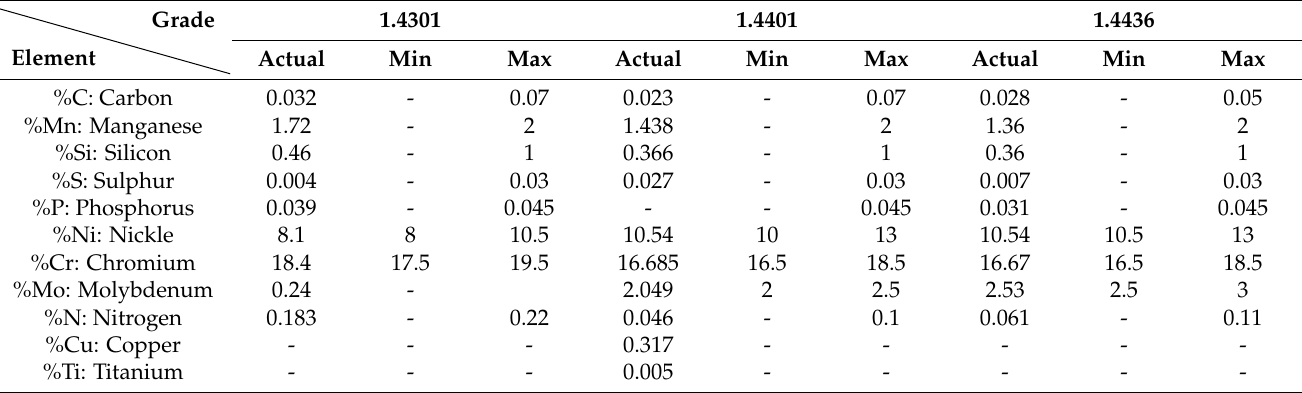
Table 2. Composition of the tested austenitic stainless